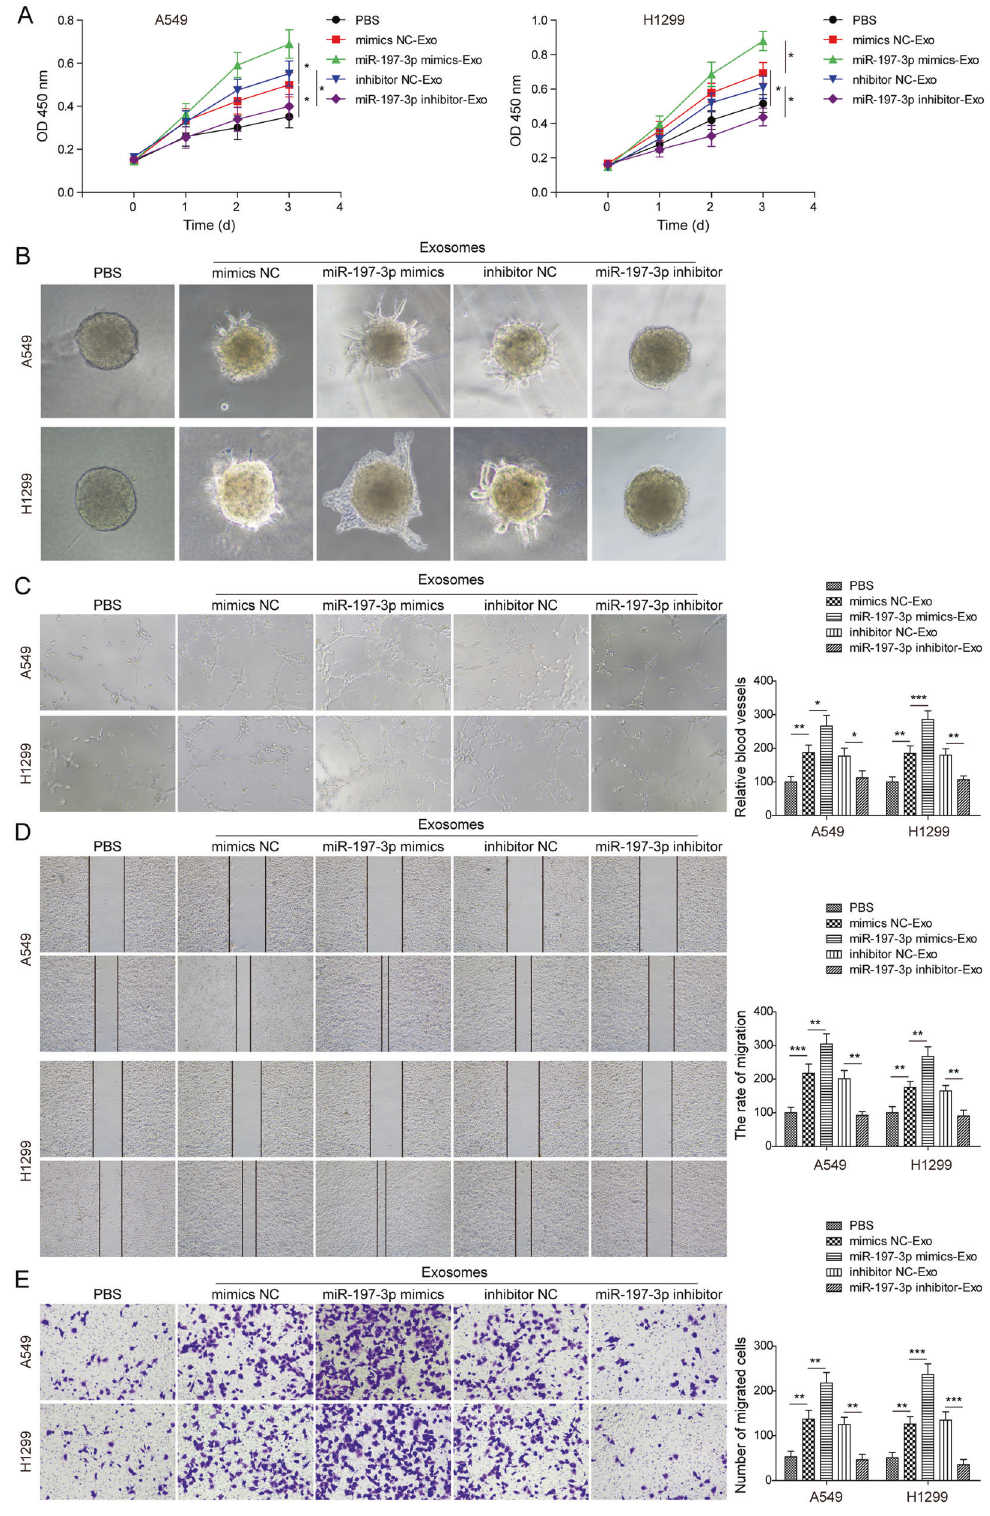
Fig. 3 Exosomal miR-197-3p promotes proliferation, angiogenesis and migration in HUVECs. A Cell proliferation was monitored by CCK-8 assay. B Angiogenesis was measured by 3D spheroid sprouting assay. C Angiogenesis was assessed by tube formation assay with quantitative analysis (right panel). D Cell migration was assessed by wound healing assay with quantitative analysis (right panel). E Migration of HUVECs was monitored by transwell migration assay with quantitative analysis (right panel). Data were representative images or were expressed as the mean ± SD of n = 3 experiments. * P < 0.05, ** P < 0.01, *** P < 0.001.